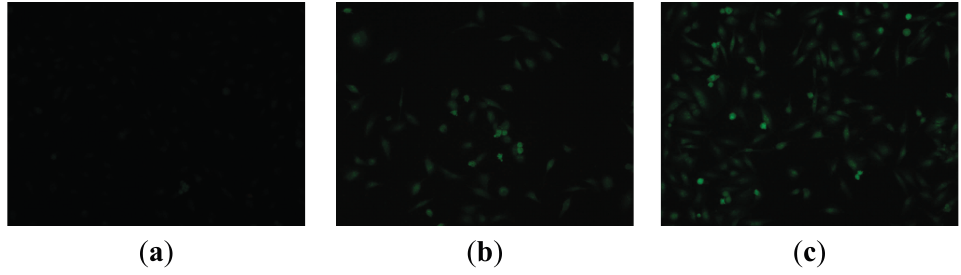
Figure 4. TUNEL assay of compound 9n in HeLa cells. ( a ) Cells not treated with the 9n were used as control for 24 h and ( b , c ) treatment with compound 9n (10 μ M) for 12 and 24 h,